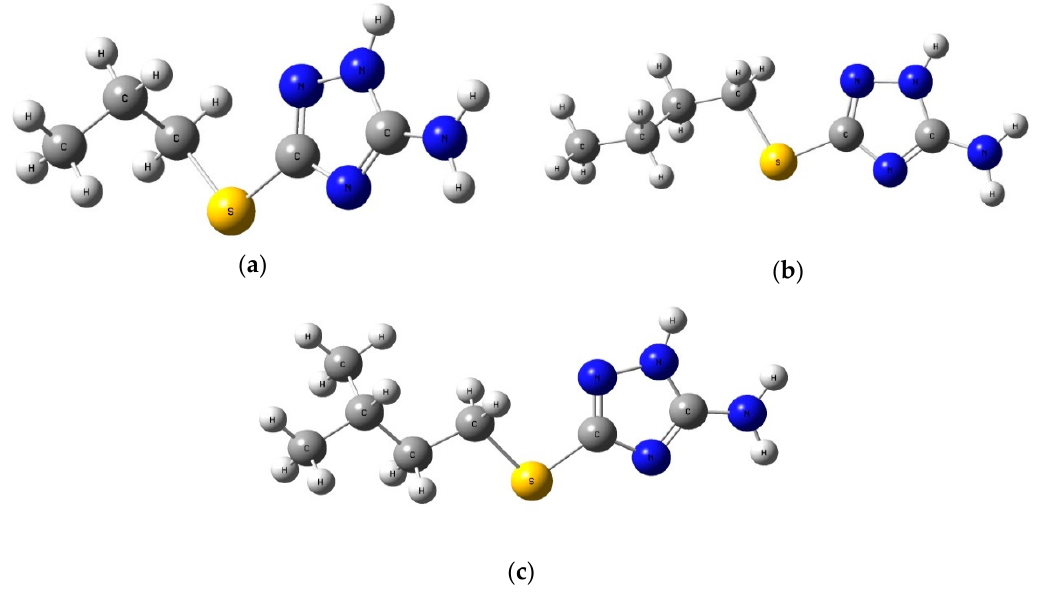
Figure 6. Optimized structures of the molecules considered for study: 3-mercaptopropyl- 5-amino-1 H -1,2,4-triazole ( a ), 3-mercaptobutyl-5-amino-1 H -1,2,4-triazole ( b ) and 3-mercapto(3-methylbutyl)-5-amino-1 H -1,2,4-triazole ( c